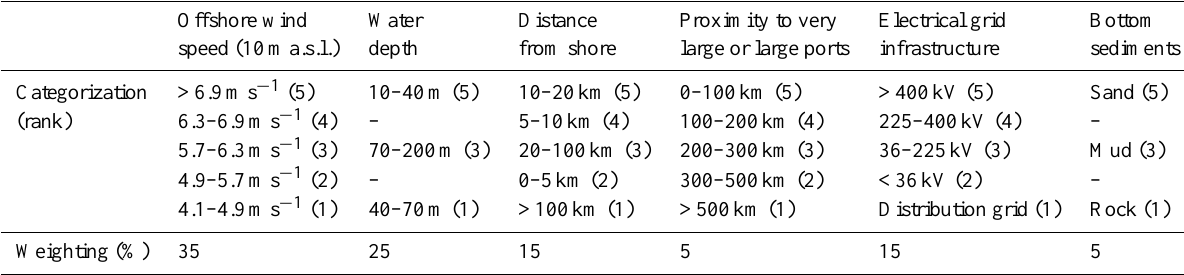
Table 1. Ranking score and corresponding weightings of potential “go” areas. Offshore wind Water